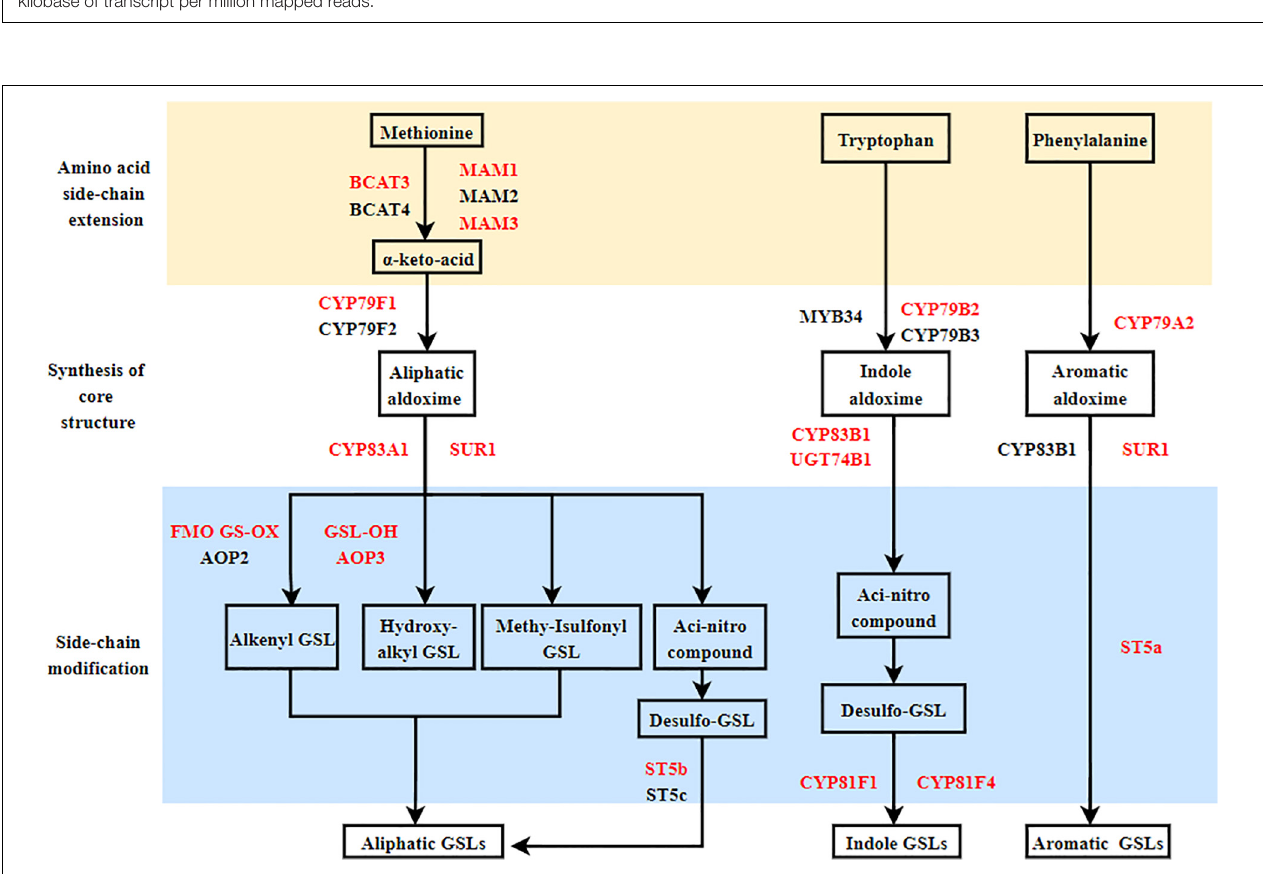
FIGURE 2 | Proposed glucosinolate (GSL) biosynthesis pathways in Chinese flowering cabbage based on the transcriptome and GSL quantification data. Red letter: Key enzymes.